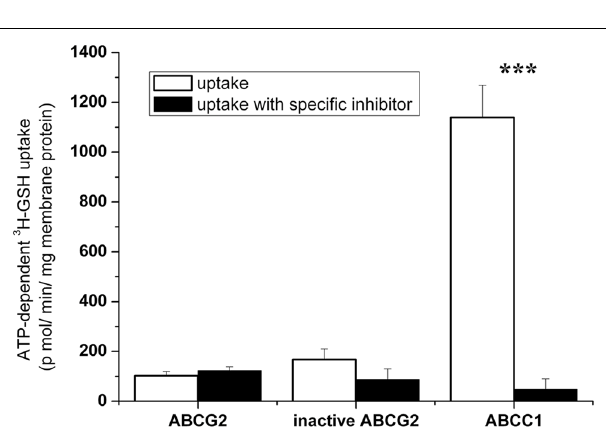
FIGURE 7 | Investigation of the transport of 3 H-GSH into wtABCG2-containing insect vesicles. Uptake of 500 μ M 3 H-GSH was measured in Sf9 vesicles expressing ABCC1, wtABCG2, or inactive ABCG2, for 5 min at 37 ◦ C. ATP-dependent transport with or without the ABCC1- or ABCG2-specific inhibitor, 4 μ M MK-571 or 1 μ M Ko143 respectively, is shown. Bars represent the average of three independent measurements ± SD values. t -test analysis: *** p <